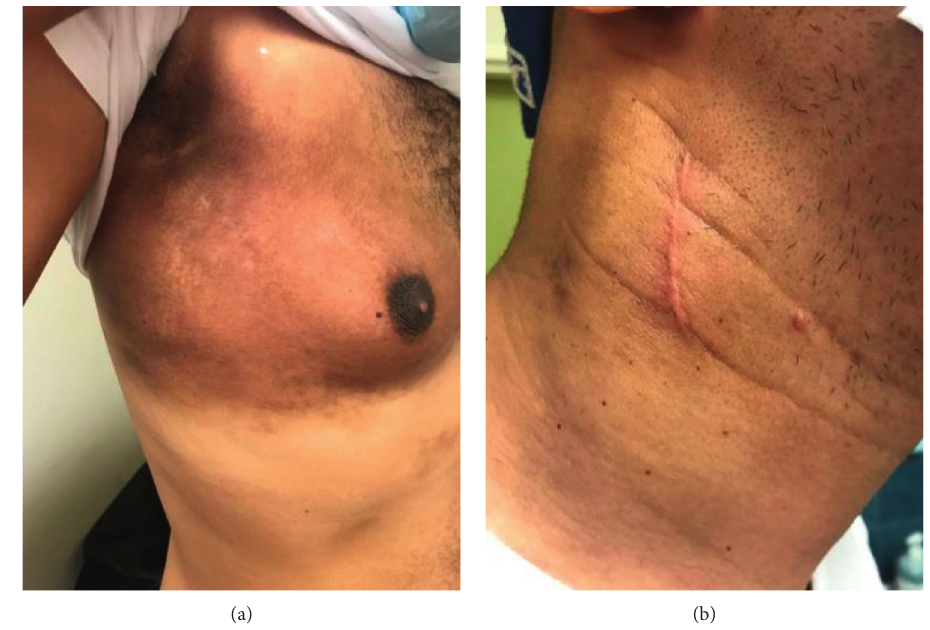
Figure 8: (a) Resolution of skin lesion. (b) Resolution of right cervical